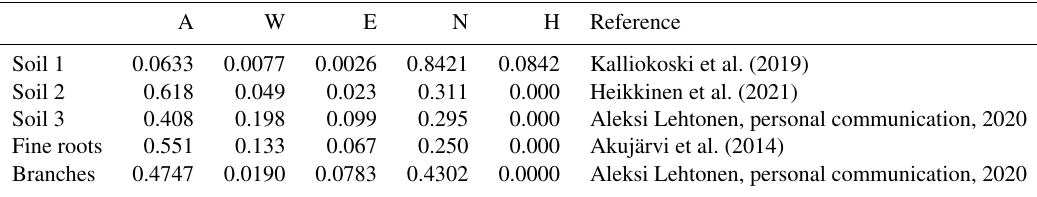
Table 3. AWENH fractions used in the Yasso model runs for the soil types and for fine roots. A W E N H Reference Soil 1 0.0633 0.0077 Soil